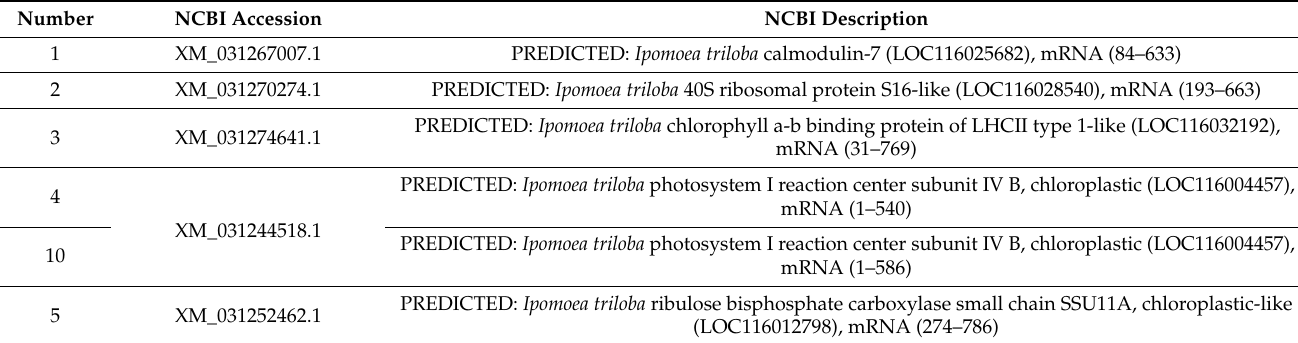
Figure 11. Identification of IbMPK3 interaction proteins using Y2H screening. ( A ) A total of 27 positive clones were screened and found to grow on SD/-Trp/-Leu medium and SD/-Trp/-Leu/-His/-Ade medium. “+” represents the positive control of the yeast two-hybrid, the combination of pNubG-Fe65 and pTSU2-APP. “ − ” shows the negative control of yeast two-hybrid, the pTSU-APP was co-transformed with pPR3N. ( B ) Semi-quantitative analysis of β -galactosidase activity in 27 initially positive clones. PC indicates positive control, and NC indicates negative control. ( C ) Rotational verification was used to acquire true positive clones after sequencing and BLAST analysis. The clones with number 13 and number 23 could not be sequenced, and the clones with number 6 and number 21 could not be grown on SD/-Trp/-Leu/-His/-Ade medium. ( D ) Semi-quantitative analysis of β -galactosidase activity in successfully sequenced positive clones. Table 1. Sequence and Blast of IbMPK3 interacting proteins.